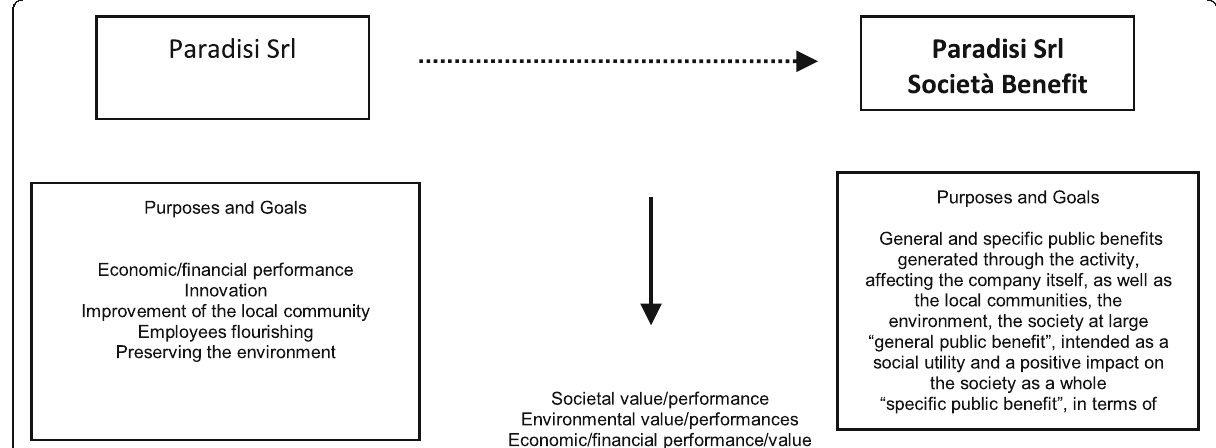
Fig. 2 Paradisi dynamic balance between economic, environmental and societal